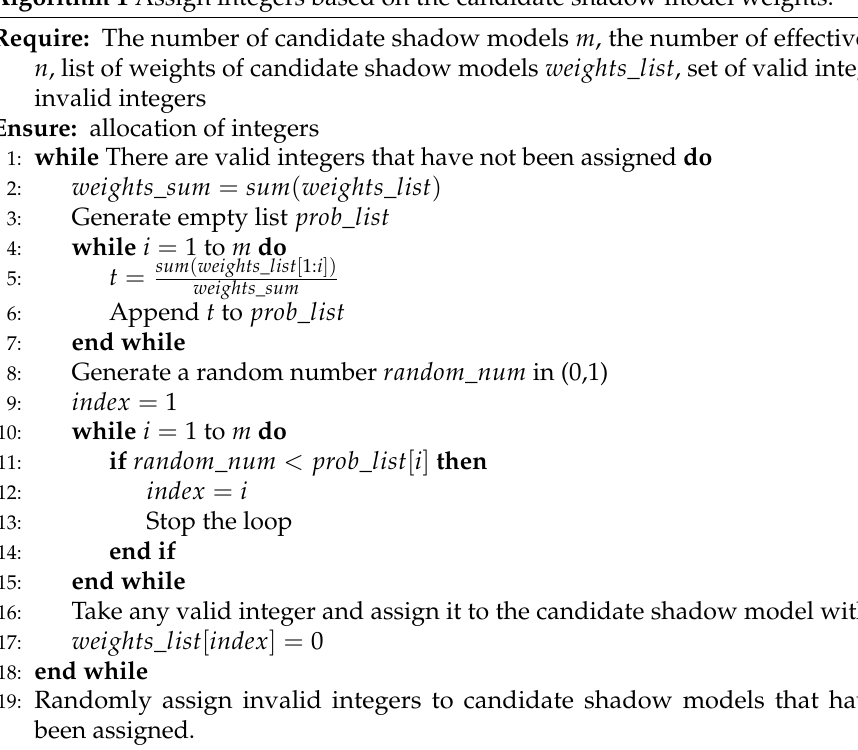
Algorithm 1 Assign integers based on the candidate shadow model